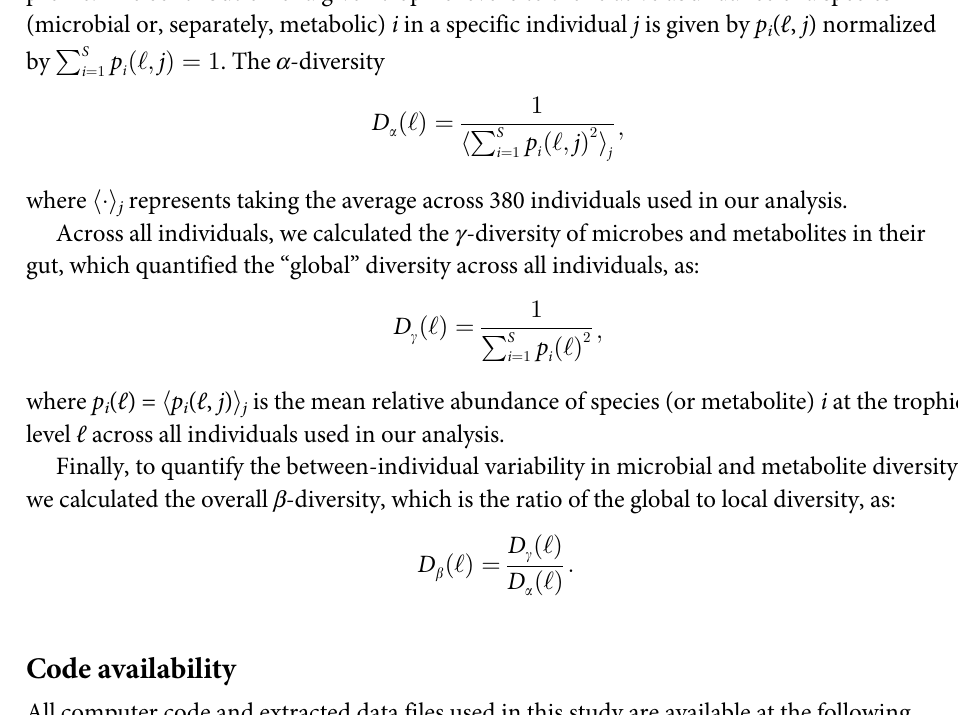
S1 Fig. Effect of changing kinetic parameters on model prediction. Scatter plot of the mea- sured and predicted metabolome where, instead of considering equal specific nutrient uptake and byproduct release rates, λ ’s in our model, we take several random sets (in black). Error bars (in black) indicate standard deviation in the predicted levels of specific metabolites for dif- ferent sets of λ ’s. The solid line represents x = y . Red squares indicate the predicted metabo- lome for the default set of kinetic parameters used, i.e., when all of λ ’s were set equal to 1. S2 Fig. Calibrating the model parameters using logarithmic accuracy. Heatmap of the loga- rithmic accuracy between experimentally measured and predicted fecal metabolomes for dif- ferent combinations of parameters f and N . The logarithmic accuracy quantifies the average ℓ order-of-magnitude error in our predicted fecal metabolome, when compared with